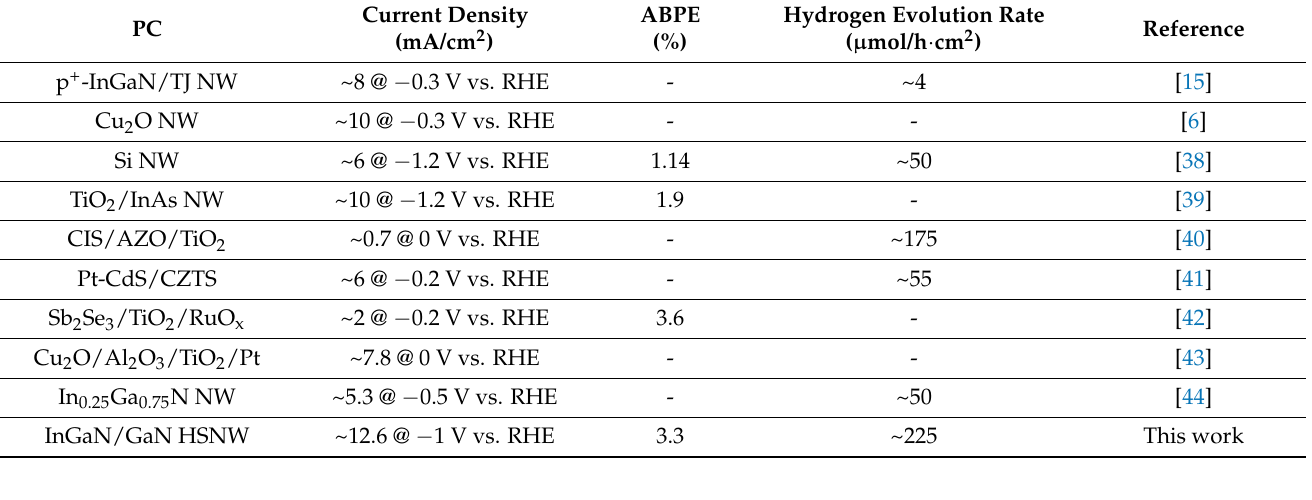
Table 1. Summary of the representative PEC-WS results of the previous PCs fabricated with various materials.